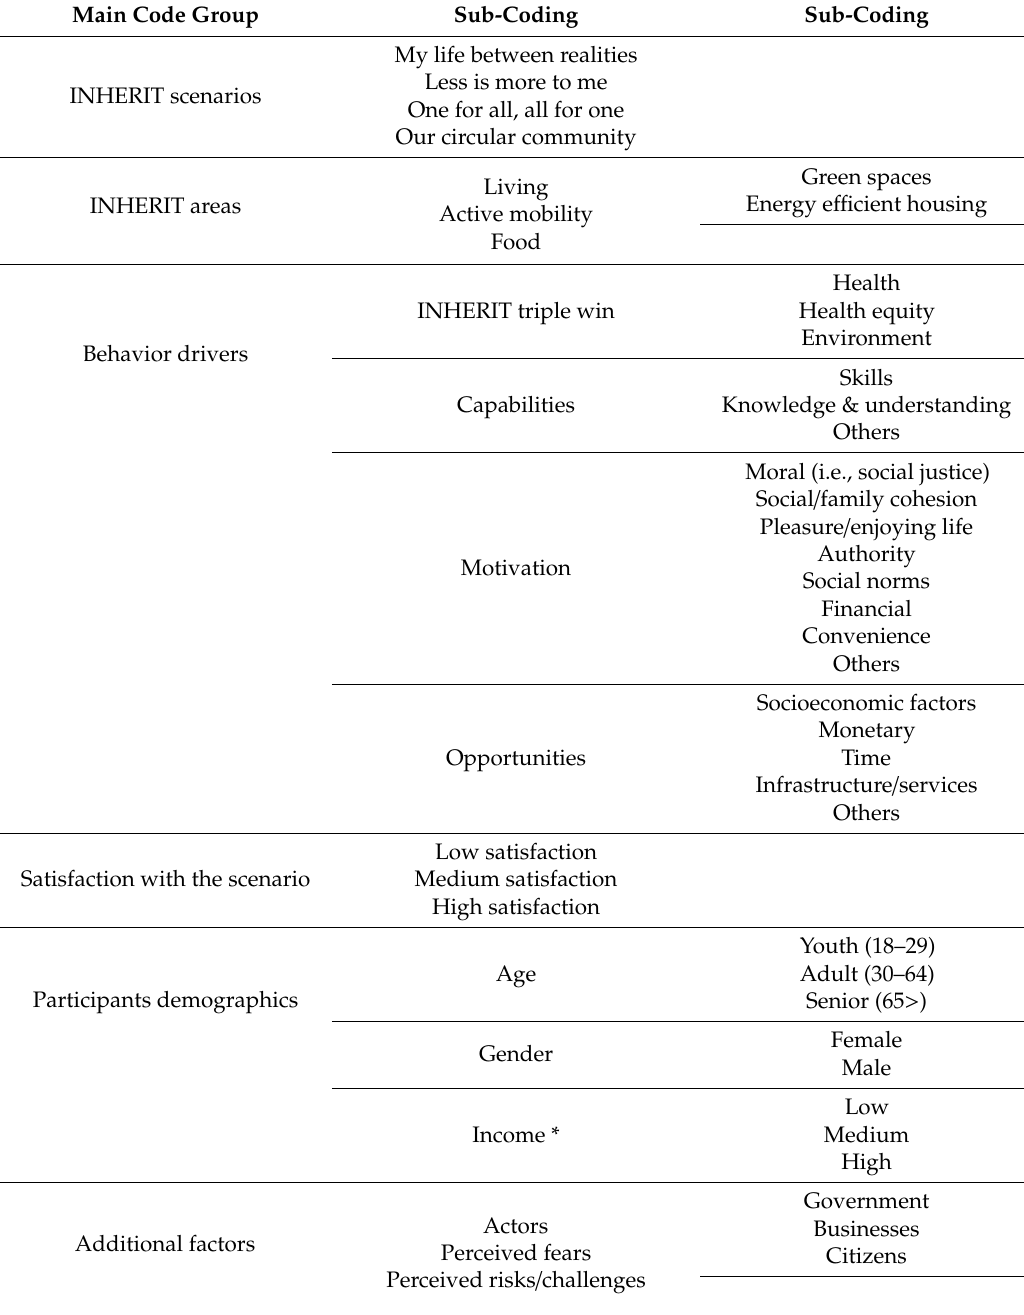
Table A1. The codebook for the qualitative content